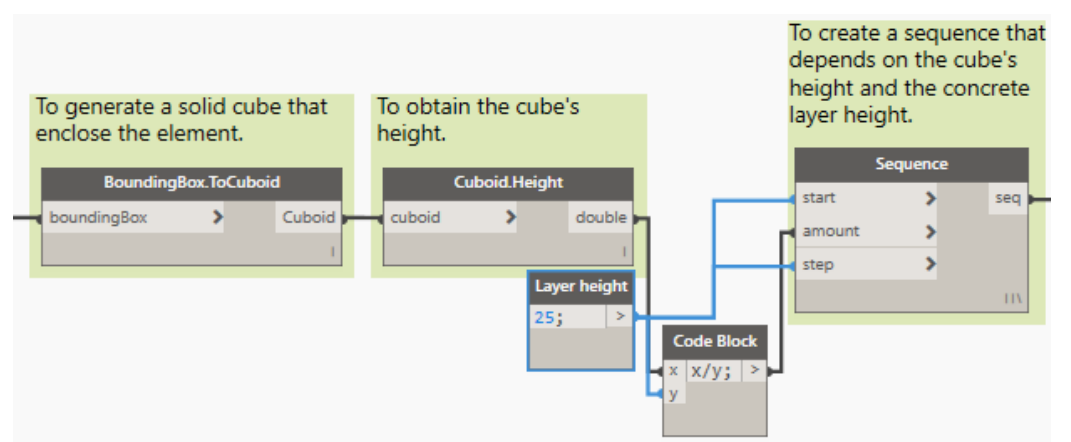
Figure A5. Obtaining the height sequence of the construction element. Next, and as shown in Figure A6, the nodes “Surface.Offset” and “Geometry.Intersect” are selected to finish creating the surfaces. Parallel to this, the output of the “Element.Solid” node is connected to the “geometry” input of the “Geometry.Intersect” node. To connect the nodes as follows: